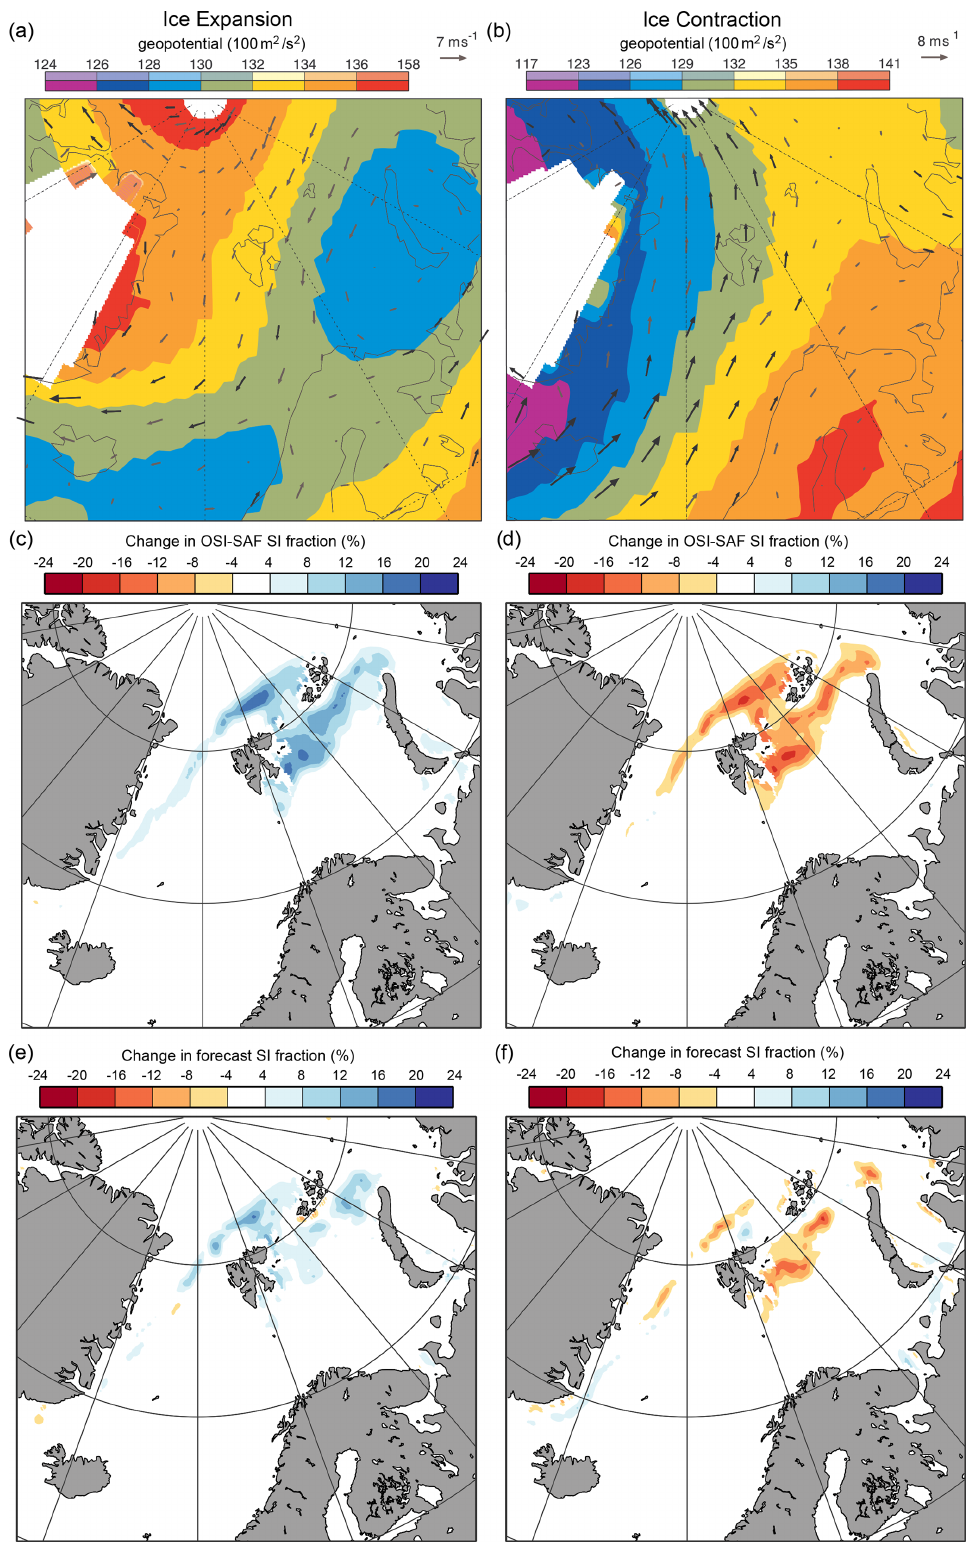
Figure 7. Composite 850hPa geopotential and vector winds for ice advance (a) and retreat (b) cases selected based on the upper and lower tercile of the 3d change in sea ice extent (SIE) in the Nordic Seas (highlighted in Fig. S2). Panels (c) and (d) are as (a) and (b) but for the 3d change in observed SIC. Panels (e) and (f) are as (c) and (d) but for the coupled